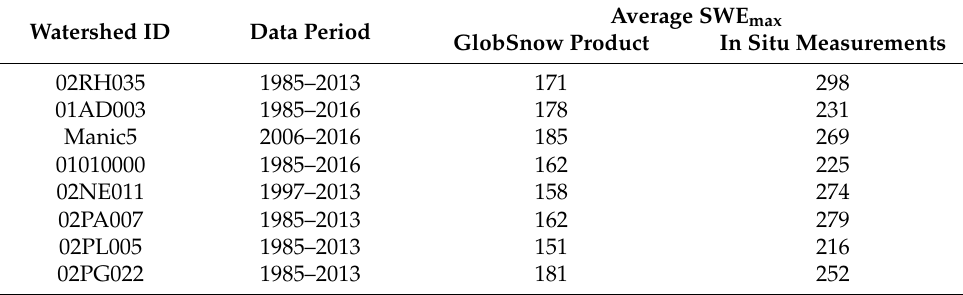
Table 2. GlobSnow and in situ seasonal maximum SWE max